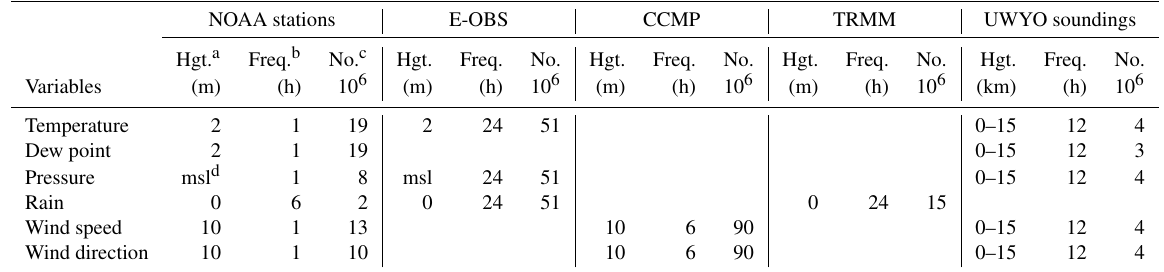
Table 2. Height, frequency and number of records of the different variables from the five datasets used for the evaluation of the AdriSC WRF 3km model over the 1987–2017 period.